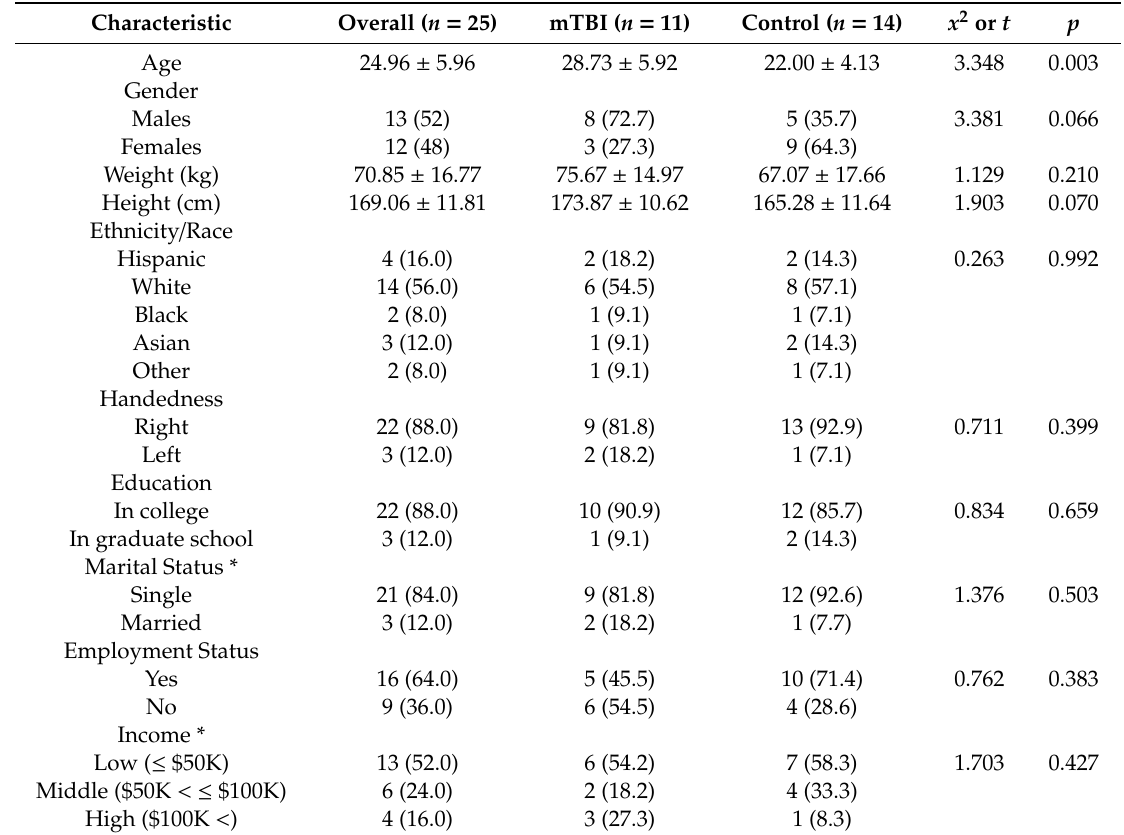
Table 1. Demographic di ff erences ( n (%) or M ± SD ) between mTBI and healthy control college student